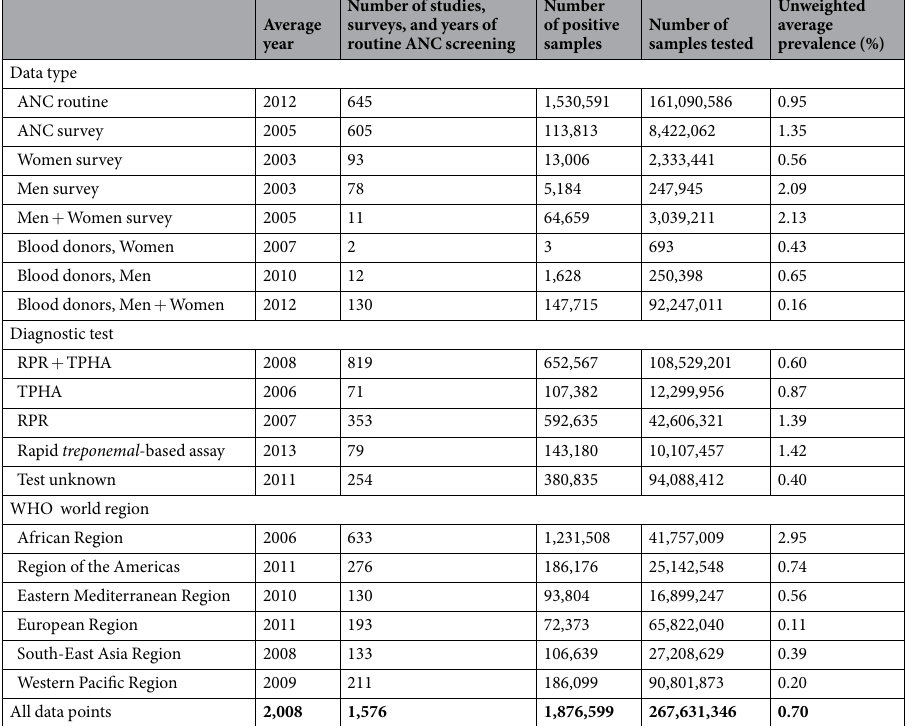
Table 1. Adult syphilis prevalence data (1990–2016), available in the Spectrum-STI global database. Notes to Table 1: Data available as of 02 May 2018. For WHO world regions, see: (http://www.who.int/about/regions/en/). ANC = Antenatal Care. RPR = Rapid plasma reagin. TPHA = Treponema pallidum hemagglutination